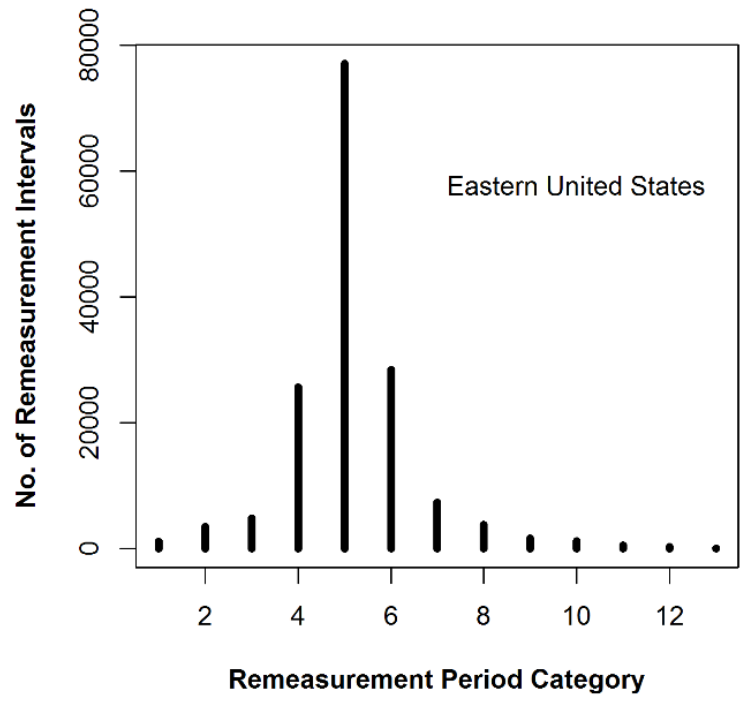
Figure 1. The interval length distribution of one ‐ year categories in FIADB for 34 States in the United States, with the end ‐ of ‐ interval measurement made between 1998 and 2016.